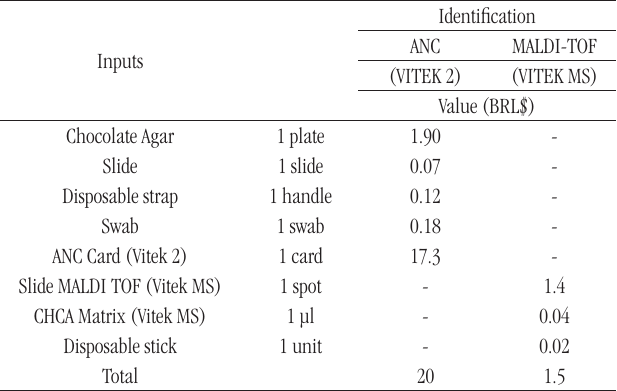
taBLE 1 − Direct cost of the inputs for the performance of culture of the anaerobes used in the study